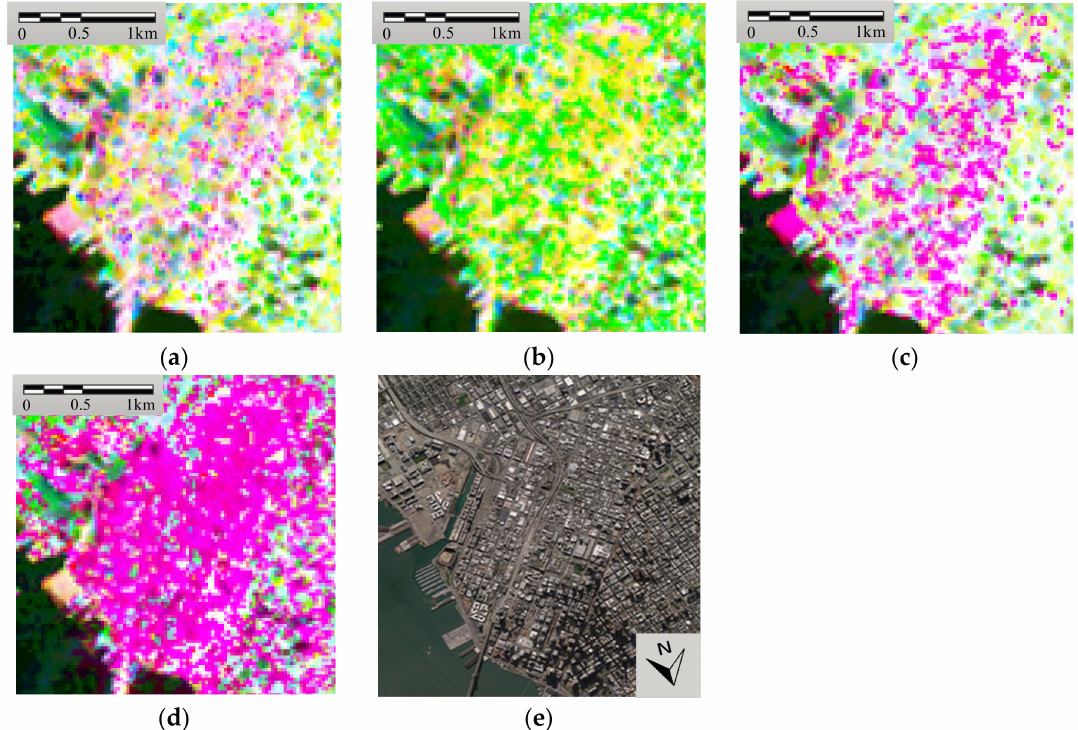
Figure 6. Enlarged fragments of color-coded representations of decomposed red box areas in Figure 4 using the: ( a ) G4U; ( b ) AG4U; ( c ) ExG4UCdr; and ( d ) ExG4URcc methods; and ( e ) the corresponding optical image. Courtesy: Google